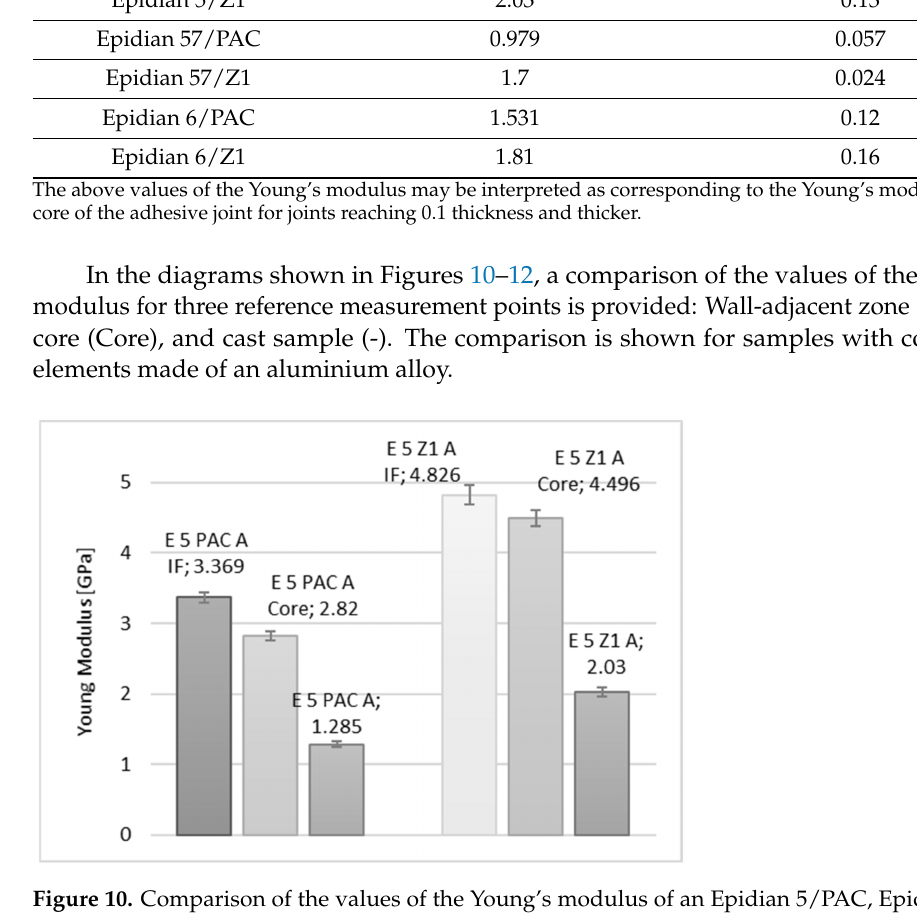
Figure 10. Comparison of the values of the Young’s modulus of an Epidian 5/PAC, Epidian 5/Z1 adhesive joint, respectively, for a joint in the wall-adjacent zone—IF, the core—Core, and for the adhesive material.